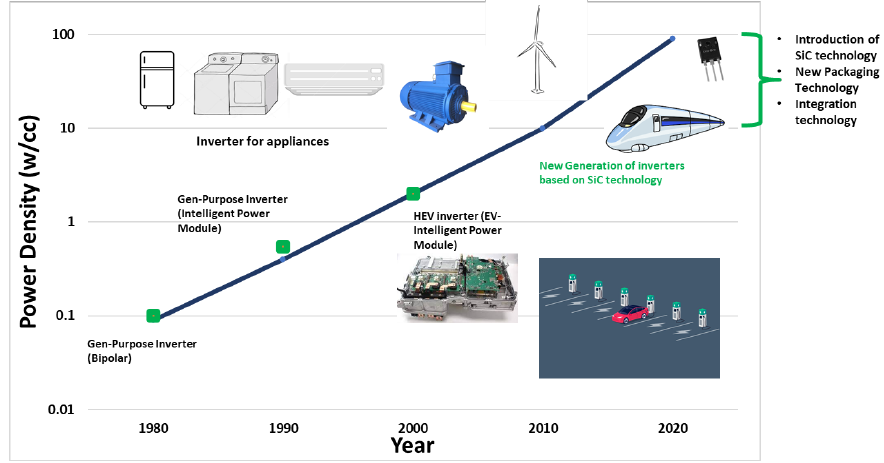
Figure 2. Power density enhancements for power electronics